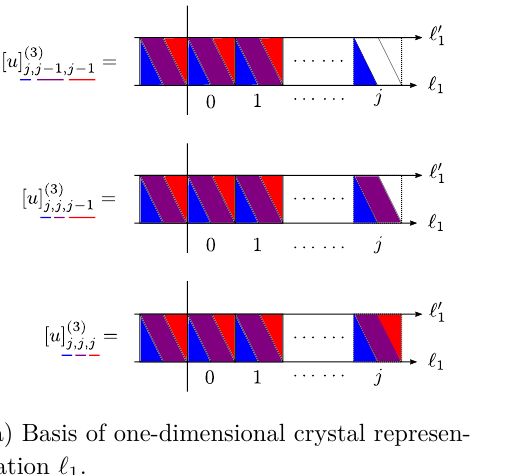
(a) Basis of one-dimensional crystal represen- tation ‘ . 1 Figure 35. Basis and coordinates of the one-dimensional crystal representation V ( ‘ 1 ) ( u ) . The one-dimensional crystal is a row of boxes with three-types of atoms in it. Each box is assigned an integer j ∈ Z , which describes the number of boxes right to the border. We note that it is counted 0 , 1 , ..